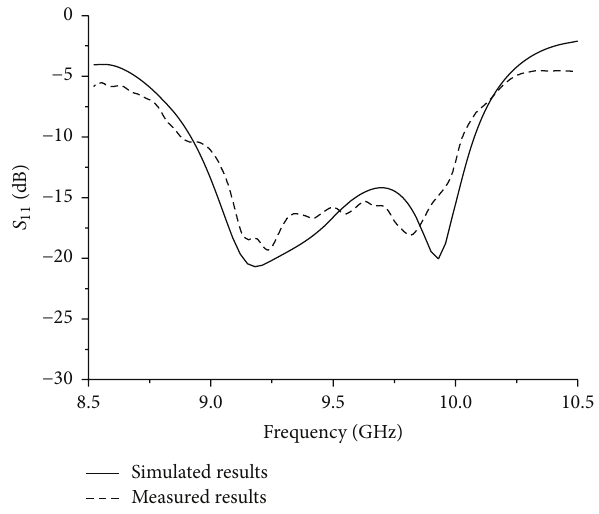
Figure 21: Reflection coefficient of the SIW Vivaldi antenna array.